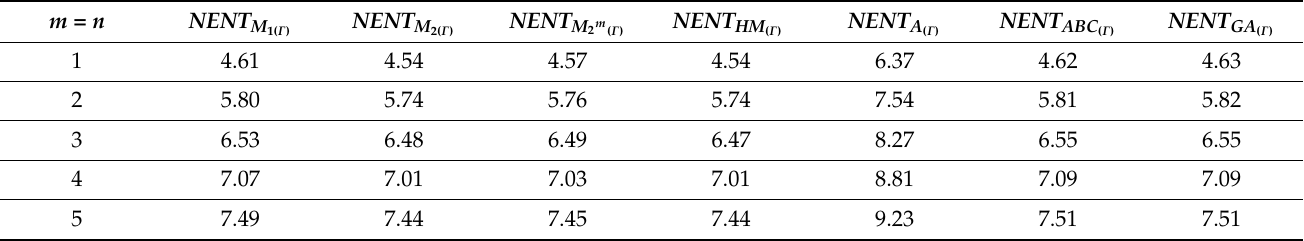
Table 15. Comparison Table for Theorem